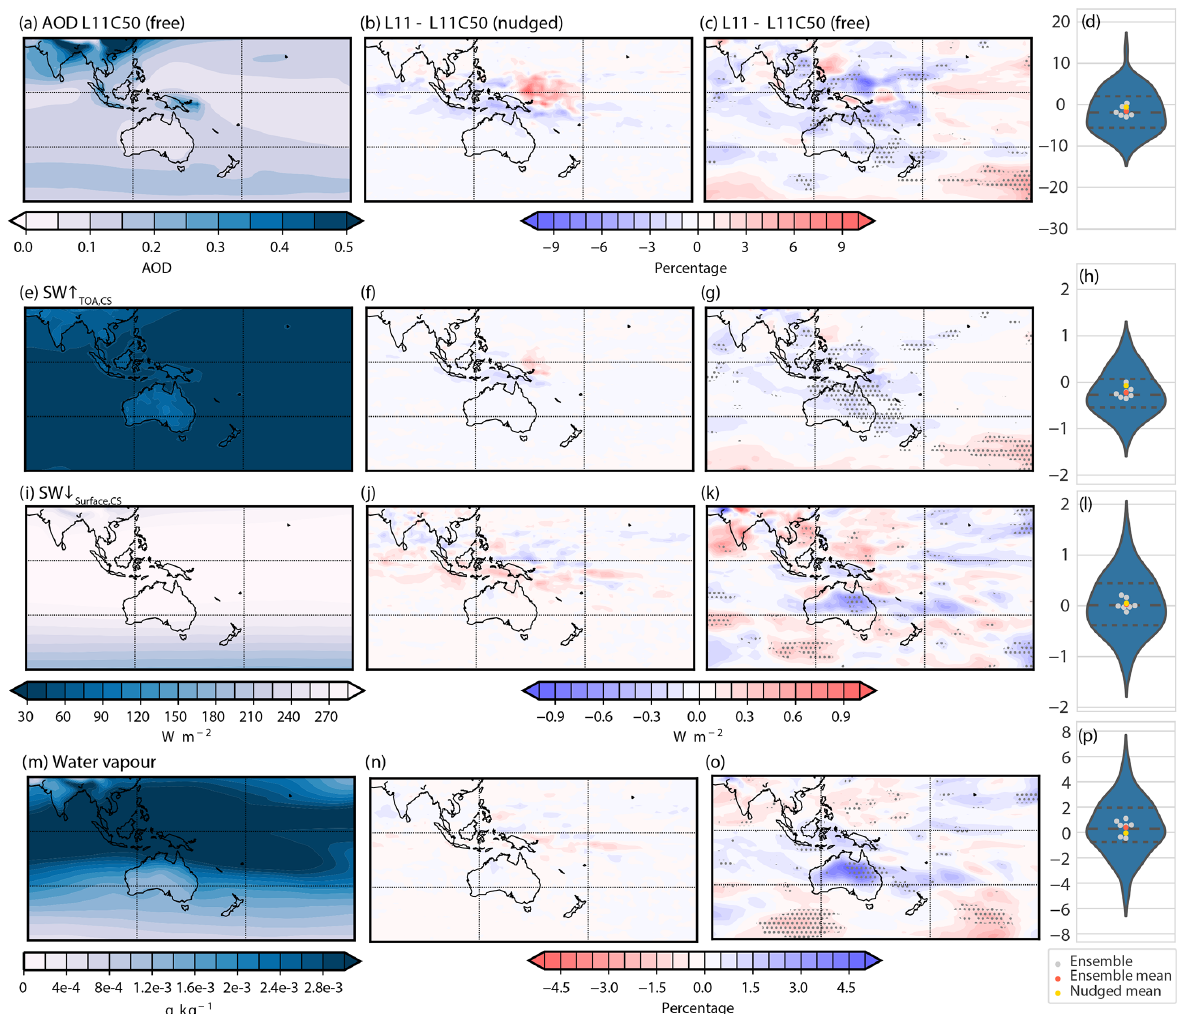
Figure 9. SON averages over the MC-Aus region for first row: the AOD (unitless and changes in percentage); second row: SW ↑ TOA , CS (Wm − 2 ); third row: SW ↓ Surf , CS (Wm − 2 ); and fourth row: column-average specific humidity (gkg − 1 and percent). The first column shows the free L11C50 simulation; the second column shows the L11–L11C50 difference for the nudged simulations; the third column shows the L11–L11C50 difference for the free-running ensemble with the model agreement shown by stippling, where at least five of the seven ensemble pairs agree in the sign of the difference; and the fourth column shows violin plots of the average seasonal differences (L11–L11C50) as a percentage for AOD and specific humidity and in watts per square metre (Wm − 2 ) for SW ↑ TOA , CS and SW ↓ Surf , CS , where all years in the ensemble are shown by the distribution; the dashed lines represent the 25, 50 and 75th percentiles; the grey dots show each pair of models mean, the red dots the ensemble average and the yellow dots the nudged